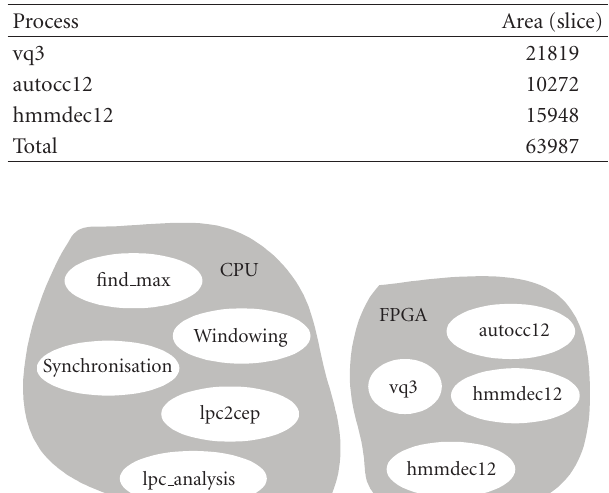
Table 3: FPGA resources of di ff erent speech process, the total area is calculated by counting two “hmmdec12”.